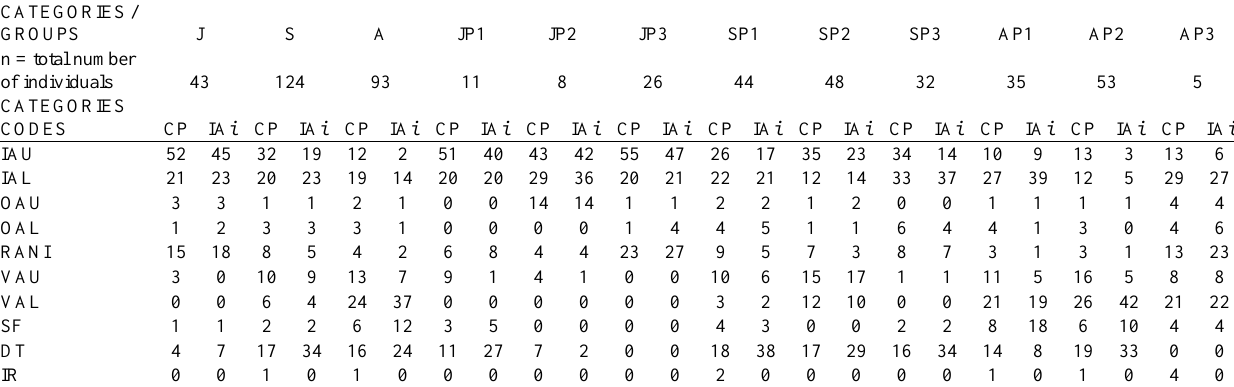
Table 2. Contribution of macroscopic diet categories in Percentage Composition (CP) and Feeding Index (IA langei grouped into three total length (Lt) categories: Juveniles (J = Lt < 3 cm), Semi-adults (S = 3 < Lt < 8 cm) and Adults (A = Lt > 8 cm), and three sites sampled along the catchment. Sampling was carried out at: site 1 (P1), an upstream first order section of the basin near its spring; site 2 (P2), a second order middle section of the basin; and site 3 (P3), a downstream third order section of the basin. The group codes mean respectively: JP1 = Juveniles Point 1, JP2 = Juveniles Point 2, JP3 = Juveniles Point 3, SP1 = Semi-adults Point 1, SP2 = Semi-adults Point 2, SP3 = Semi-adults Point 3, AP1 = Adults Point 1, AP2 = Adults Point 2 and AP3 = Adults Point 3. The diet category codes mean respectively: IAU = Autochthonous Insects, IAL = Allochthonous Insects, OAU = Other Autochthonous Arthropods, OAL = Other Allochthonous Arthropods, RANI = Non Identifiable Arthropod Parts, VAU = Autochthonous Plants, VAL = Allochthonous Plants, SF = Fruits and Seeds, DT = Detritus, and IR = Remaining